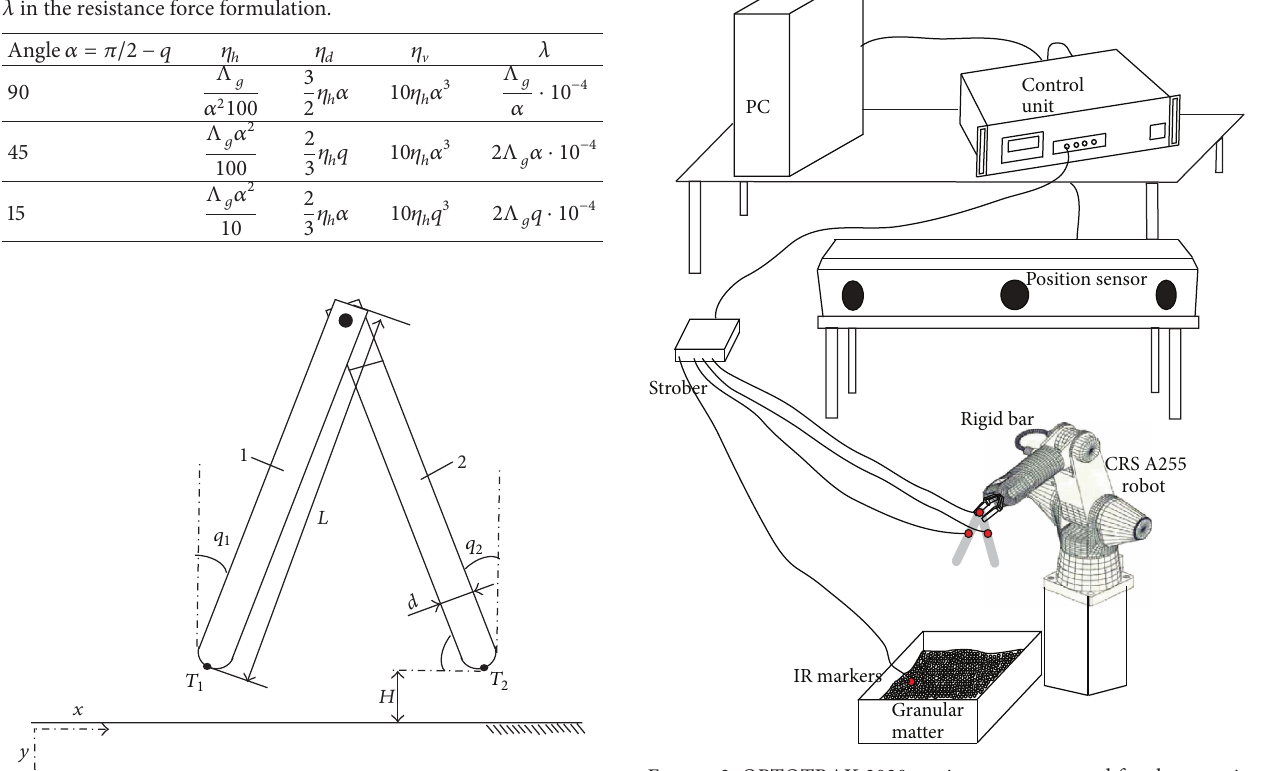
Figure 3: OPTOTRAK 3020 equipment setup used for the experi- mental study of the impact of a two-link kinematic chain with two points of impact with granular